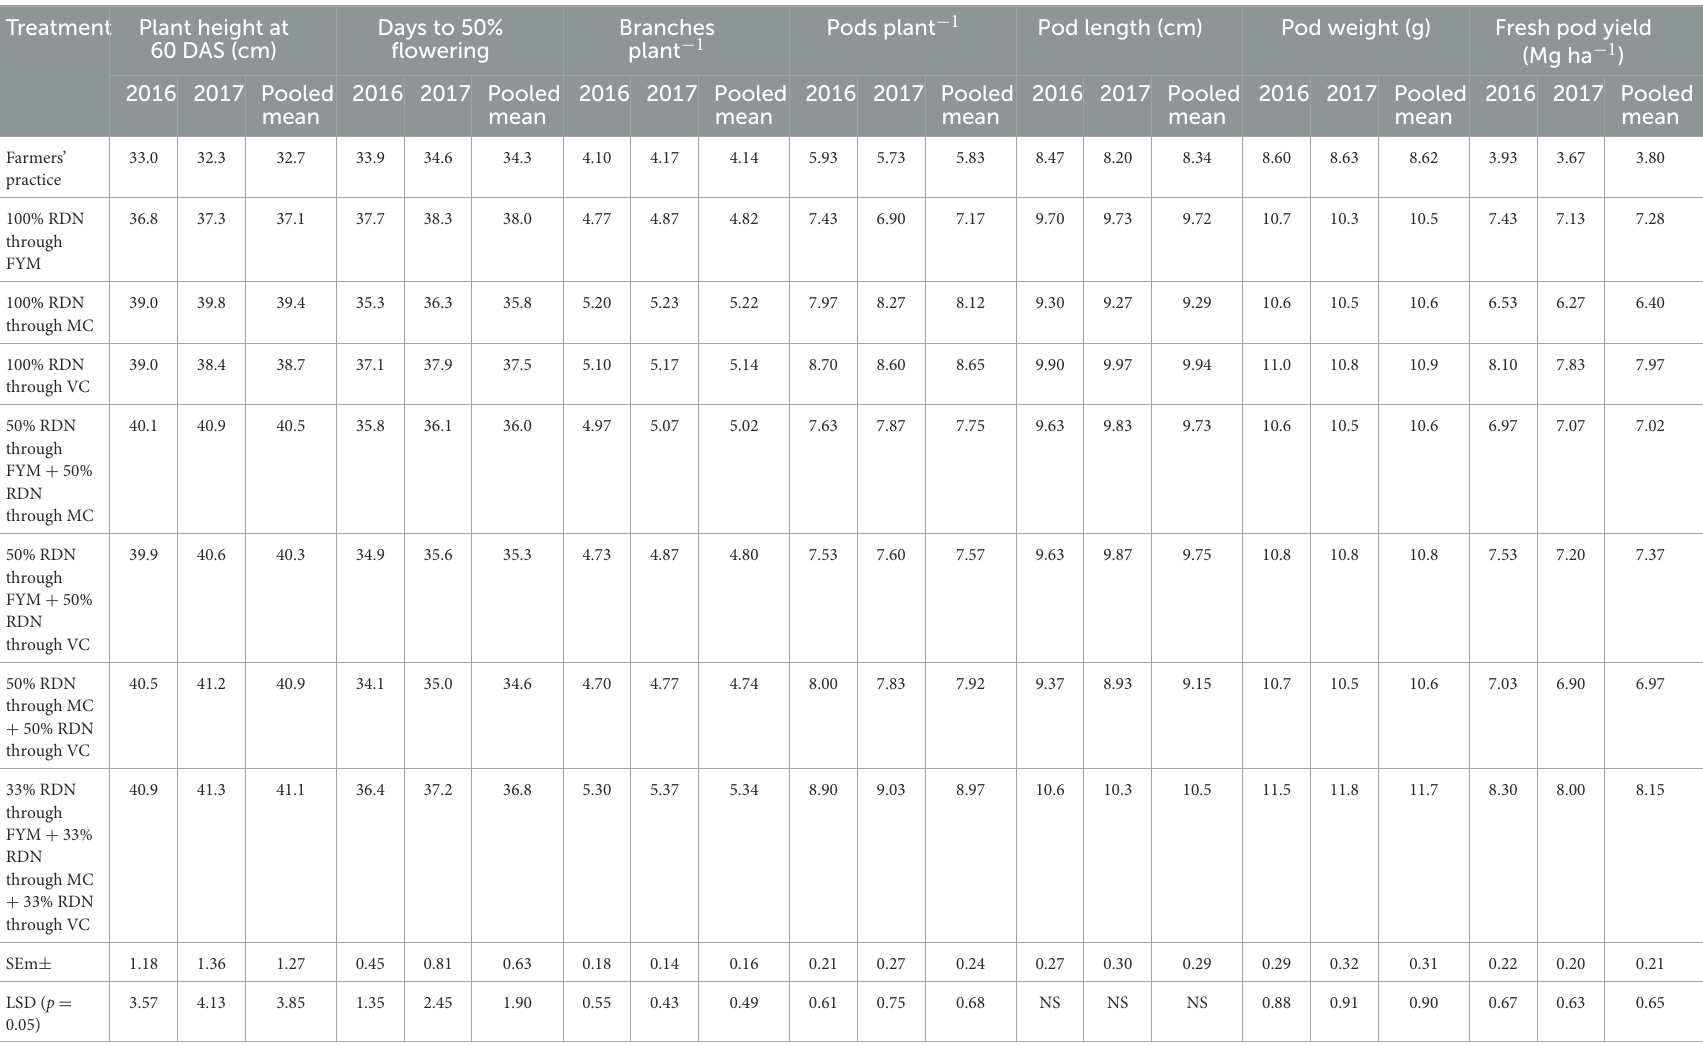
TABLE 1 Effects of conjoint application of organic sources of nutrients on growth, yield attributes, and yield of French bean crop.